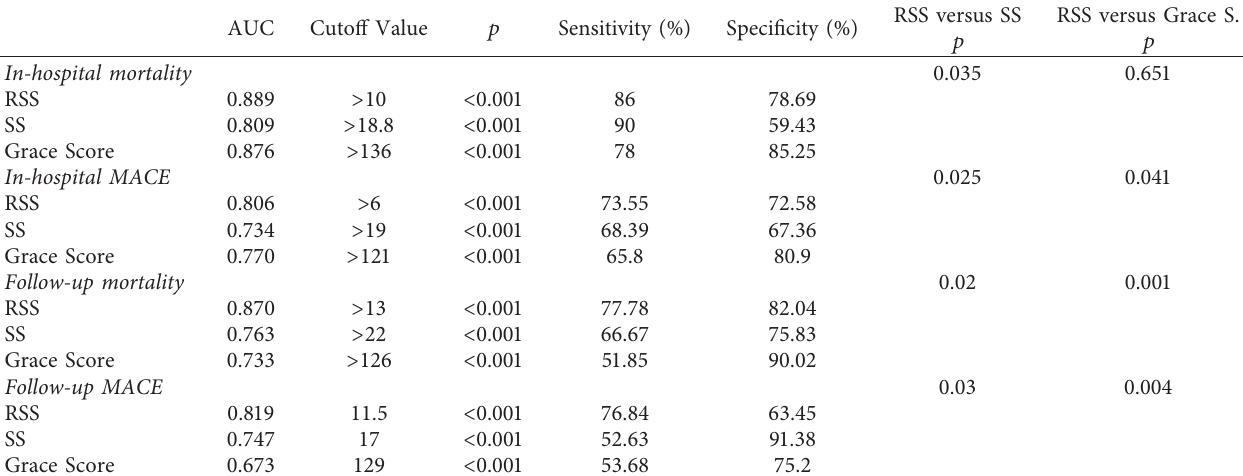
Table 7: Cutoff values and comparison results of RSS, SS, and Grace Scores related to in-hospital and follow-up primary and secondary